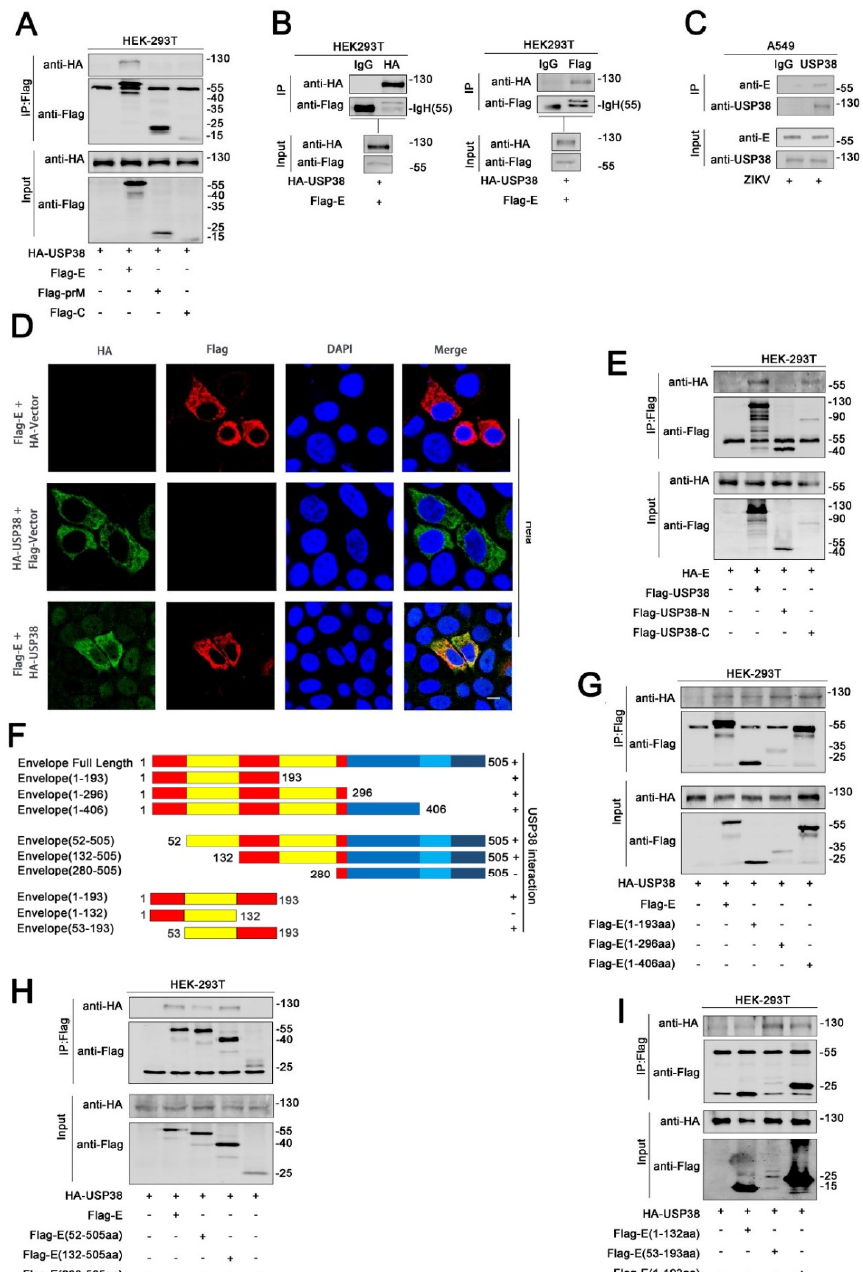
Figure 2. USP38 binds to E protein through its C-terminal domain. ( A ) HEK293T cells were co-transfected with HA-USP38 and Flag-E, Flag-C, Flag-prM, cell lysates were subjected to IP using anti-flag antibody and analyzed by immunoblotting. ( B ) HEK293T cells were co-transfected with HA-USP38 and Flag-E. Cell lysates were subjected to IP using control IgG, anti-HA, or anti-Flag antibody. ( C ) A549 cells was infected with ZIKV for 48 h. Cell lysates were subjected to IP using control IgG or anti-USP38. ( D ) Hela cells were transfected with HA-USP38 or Flag-E, or co-transfected with HA-USP38 and Flag-E. The sub-cellular localizations of HA-USP38 (green), Flag-E (red), and nucleus marker DAPI (blue) were analyzed with confocal microscopy. Bar = 5 µ m. ( E ) HEK293T cells were co-transfected with HA-E and Flag-USP38, Flag-N-terminal-USP38 or Flag-C-terminal-USP38. Cell lysates were subjected to IP using anti-Flag antibody and analyzed by immunoblotting. ( F ) Schematic diagram of the full-length E protein and truncated E proteins: E (1–193aa), E (1–296aa), E (1–406aa), E (52–505aa), E (132–505aa) E (280–505aa). ( G , H ) HEK293T cells were co-transfected with HA-USP38 and Flag-E, Flag-E (1–193aa), Flag-E (1–296aa), and Flag-E (1–406aa) ( G ) or Flag-E, Flag-E (52–505aa), Flag-E (132–505aa), and Flag-E (280-505aa) ( H ). Cell lysates were subjected to IP using anti-Flag antibody and analyzed by immunoblotting ( G , H ). ( I ) HEK293T cells were co-transfected with HA-USP38 and Flag-E (1–193aa), Flag-E (1–132aa), or Flag-E (53–193aa). Cell lysates were subjected to IP using anti-Flag antibody and analyzed by